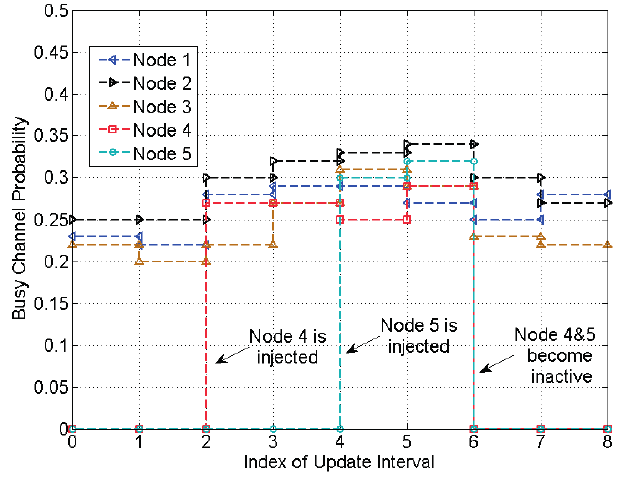
Figure 8. Busy channel probability in a heterogeneous network with changes on the number of